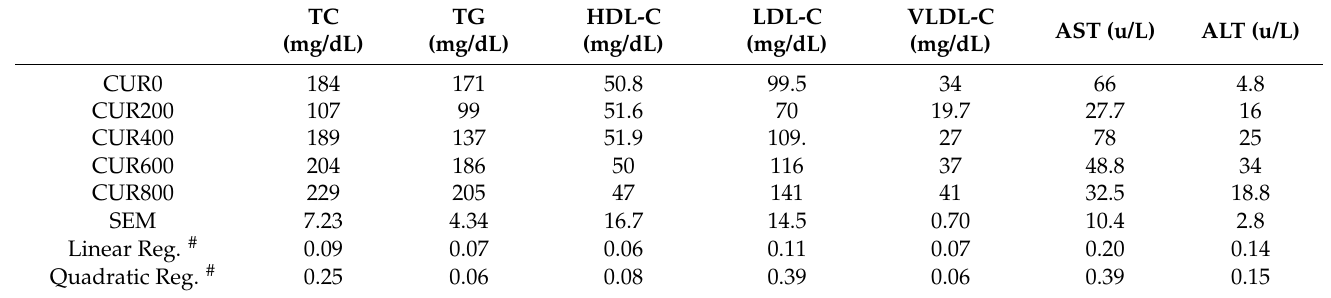
Table 5. The effects of dietary curcumin (CUR) on the blood biochemical parameters of O. niloticus